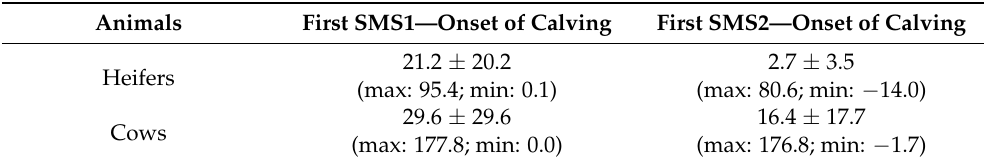
Table 2. Time (h; median ± median absolute deviation; maximum, minimum) elapsed between first SMS1 (enhanced activity registered over one hour) and SMS2 (high activity continued during the consecutive hour) emitted by the remote calving sensor Moocall ® and the onset of calving in heifers ( n = 16) and cows ( n = 8; p > 0.05). Animals First SMS1—Onset of Calving First SMS2—Onset of Calving 21.2 ± 20.2 Heifers Cows (max: 176.8; min: − 1.7)